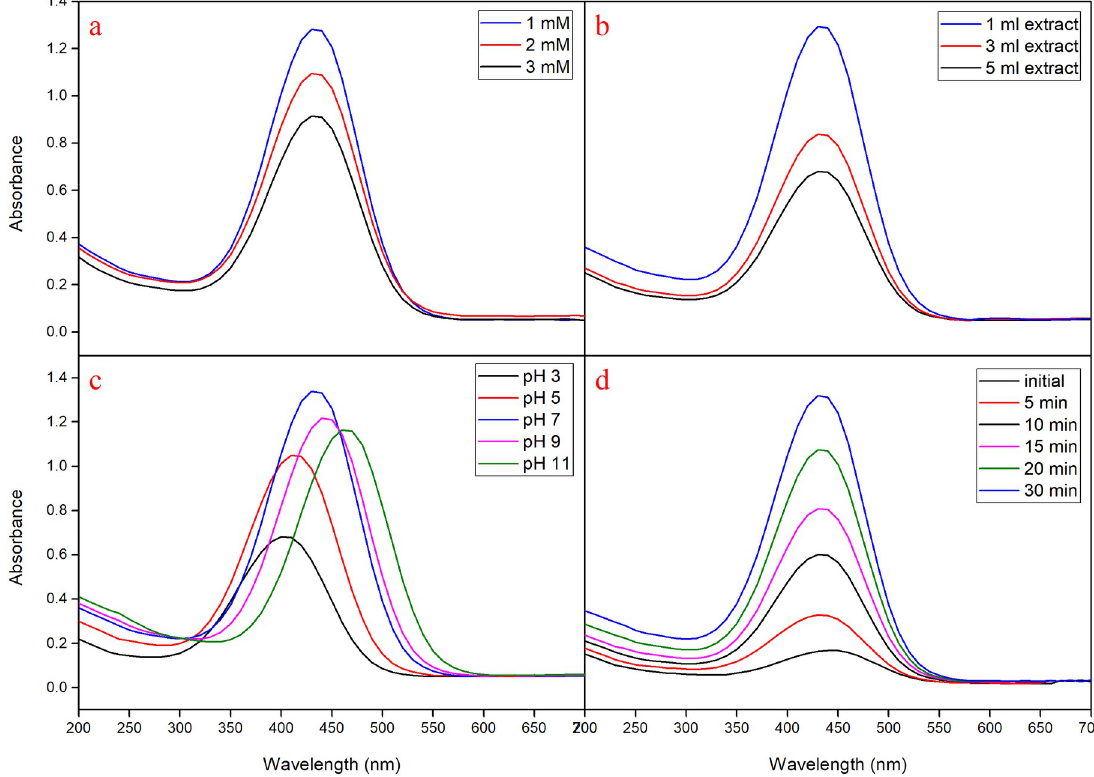
Fig 2. (a) UV–vis spectra of aqueous silver nitrate concentration. (b) Concentration ratio of Mang Mao extract with 1 mM silver nitrate. (c) Different pH range. (d) Different time